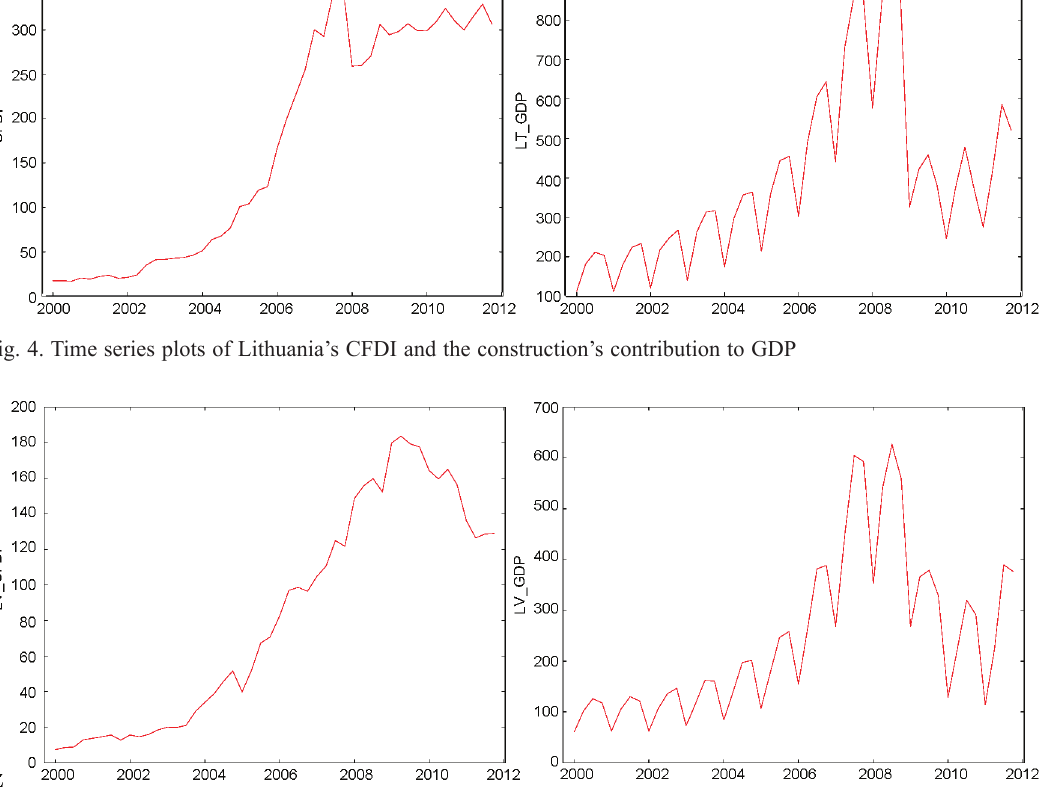
Fig. 5. Time series plots of Latvia’s CFDI and the construction’s contribution to